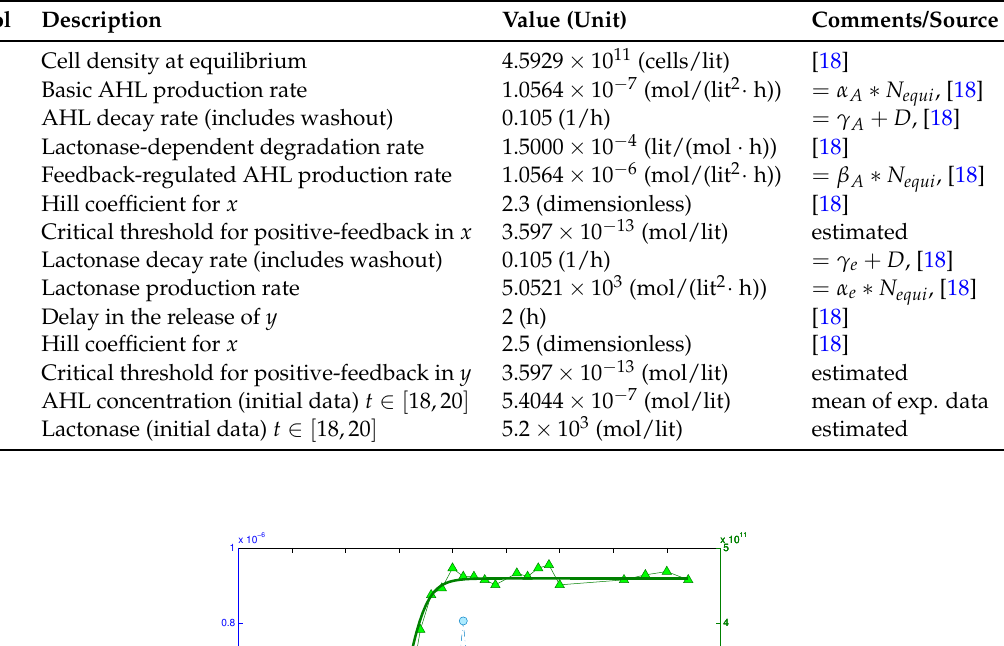
Table 1. Variables and parameters in model (8), with values used for data fit in Figure 3.